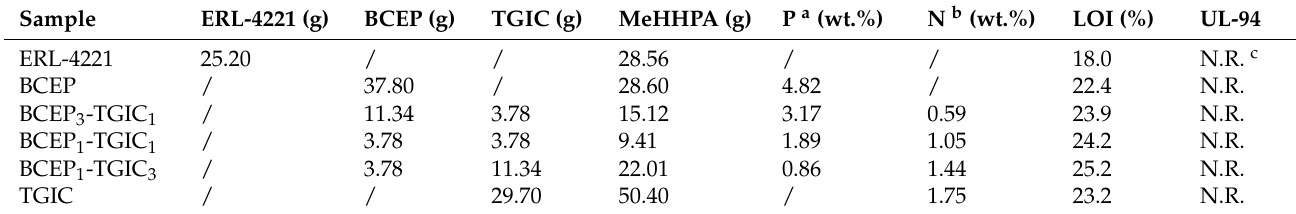
Table 2. Formula and flame retardancy test results of the epoxy system.